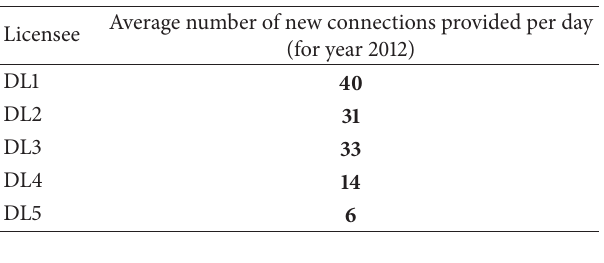
Table 3: Average number of new connections provided by each DL.